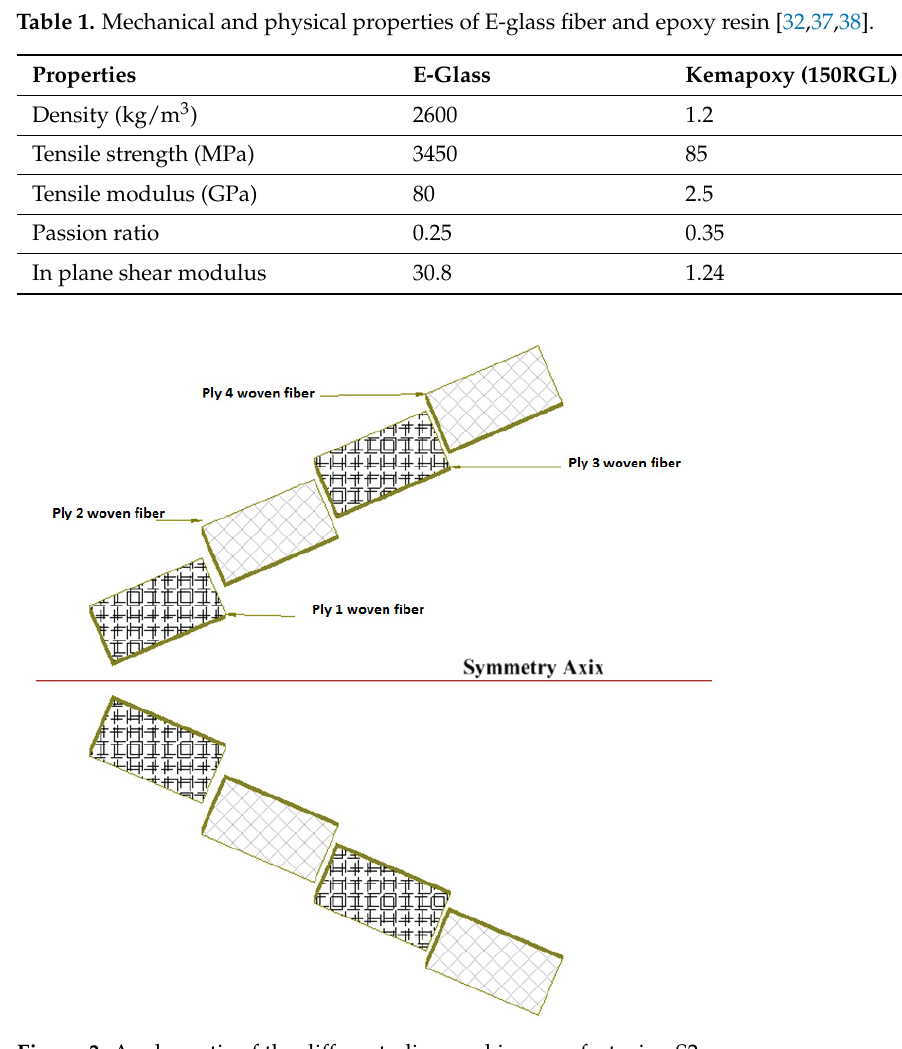
Figure 3. A schematic of the different plies used in manufacturing